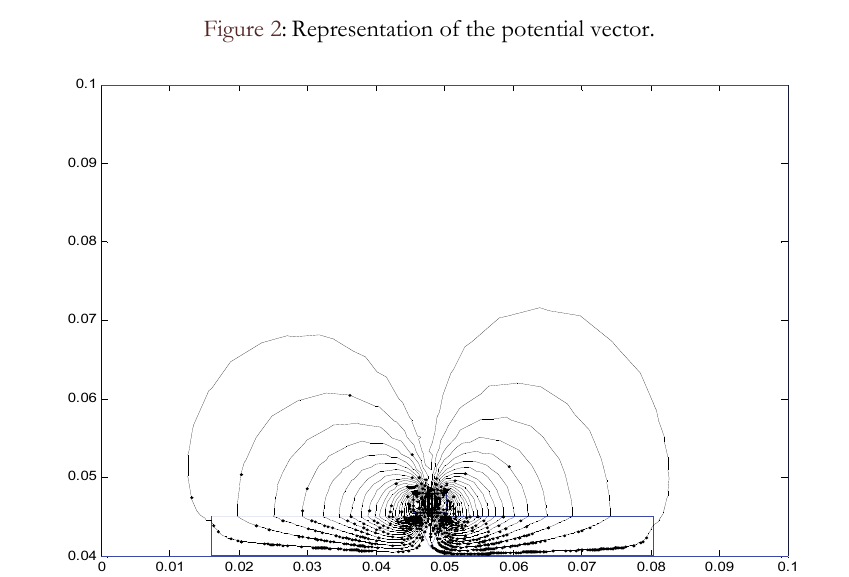
Figure 3: Circulation of the field